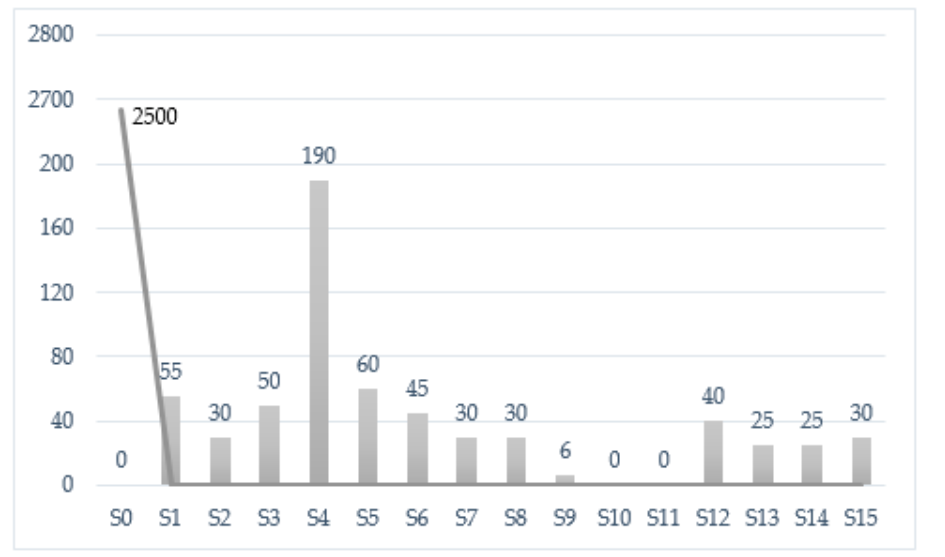
Figure 10. Various effects for C 1 and 16-embedded-system layout.